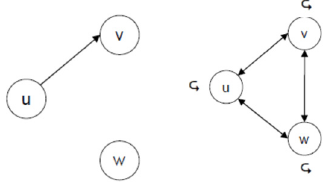
Figure 11. Representation of the Kripke F with W = { u , v , w } and with ( Left ) ( R ⊆ u , v ) , where v is accessed by u and not vice versa while w is irrelated. ( Right ) with ( R ⊆ W × W ) to define an equivalence class of possible worlds, or universe because all satisfy the reflexive, symmetric, and transitive accessibility relations among them. In parentheses, the right graph is a representation of a S5 (KT45) modal system, as we see.